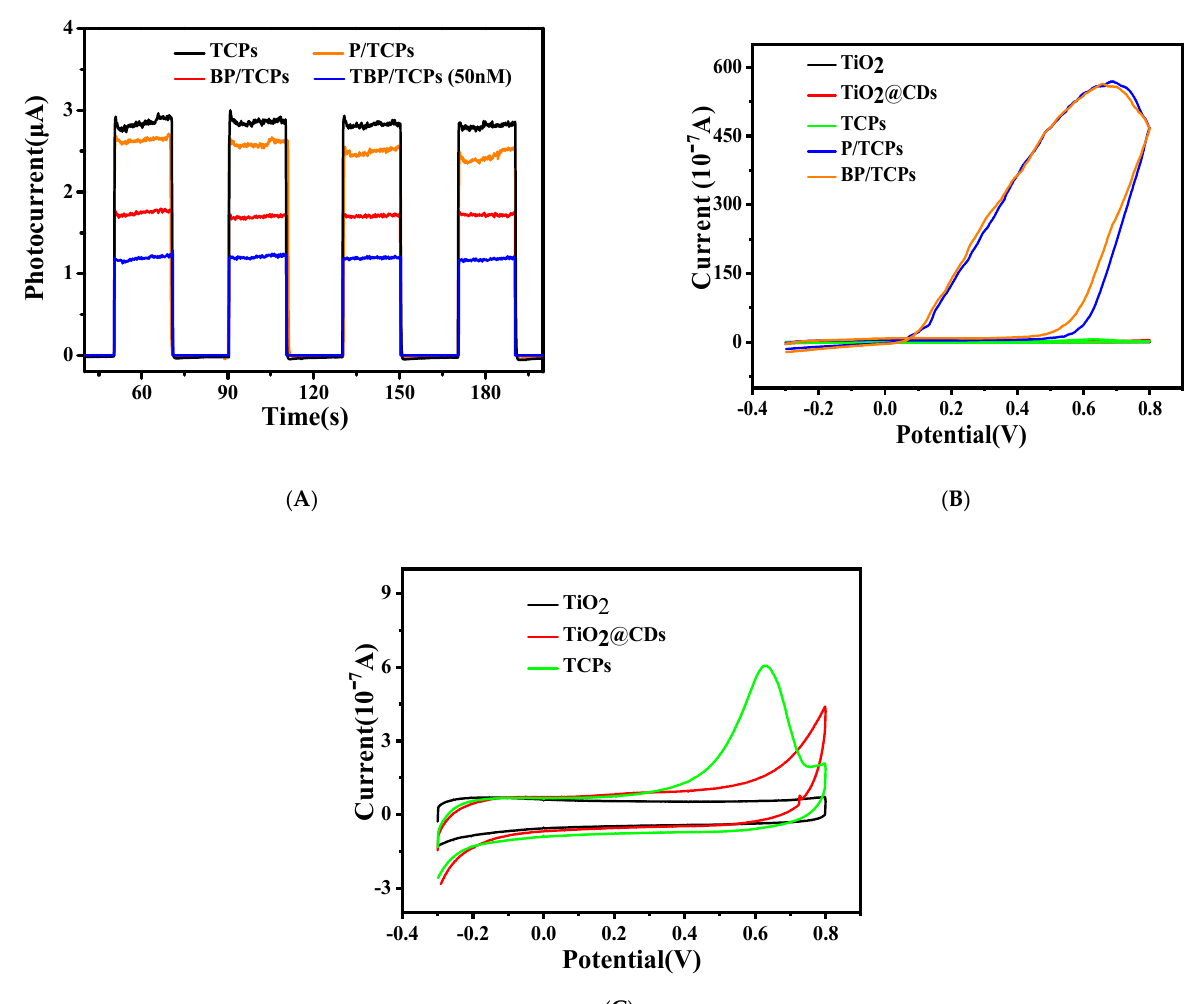
Figure 4. ( A ) PEC characterization, ( B , C ) CV curves of the different electrodes. The effect of incubation time on photocurrent was investigated. We dripped 10 μ L 50 nM of T-DNA on the constructed electrode and incubated for diverse times. The re- sults are shown in Figure 5A exhibit that the photocurrent reduced to 1.2 μ A when the incubation time was up to 60 min. After the incubation time exceeded 60 min, the pho- tocurrent remained unchanged with the incubation time increasing. This indicates that the T-DNA completely combined with P-DNA for 60 min. Therefore, the incubation time of 60 min was selected.